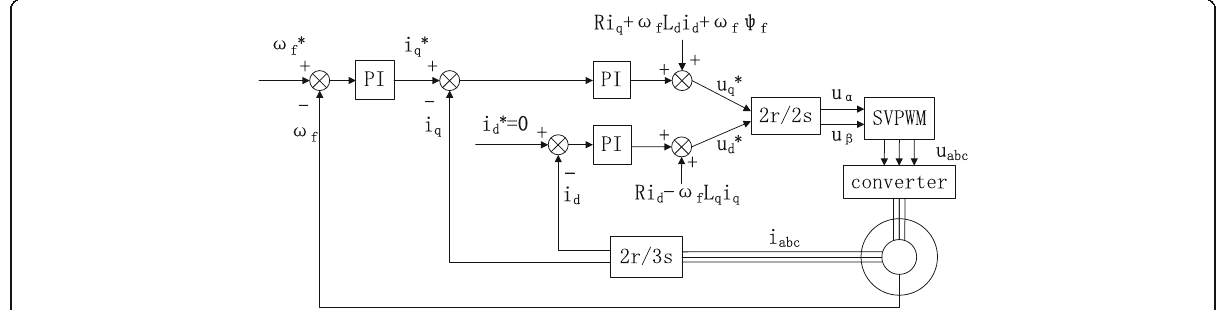
Fig. 5 Structure of outer rotor maximum power point tracking